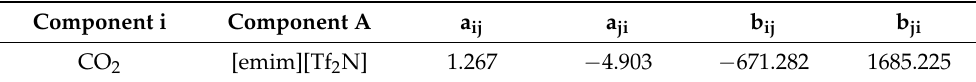
Table 3. NRTL binary parameters of CO 2 with [emim][Tf 2 N].